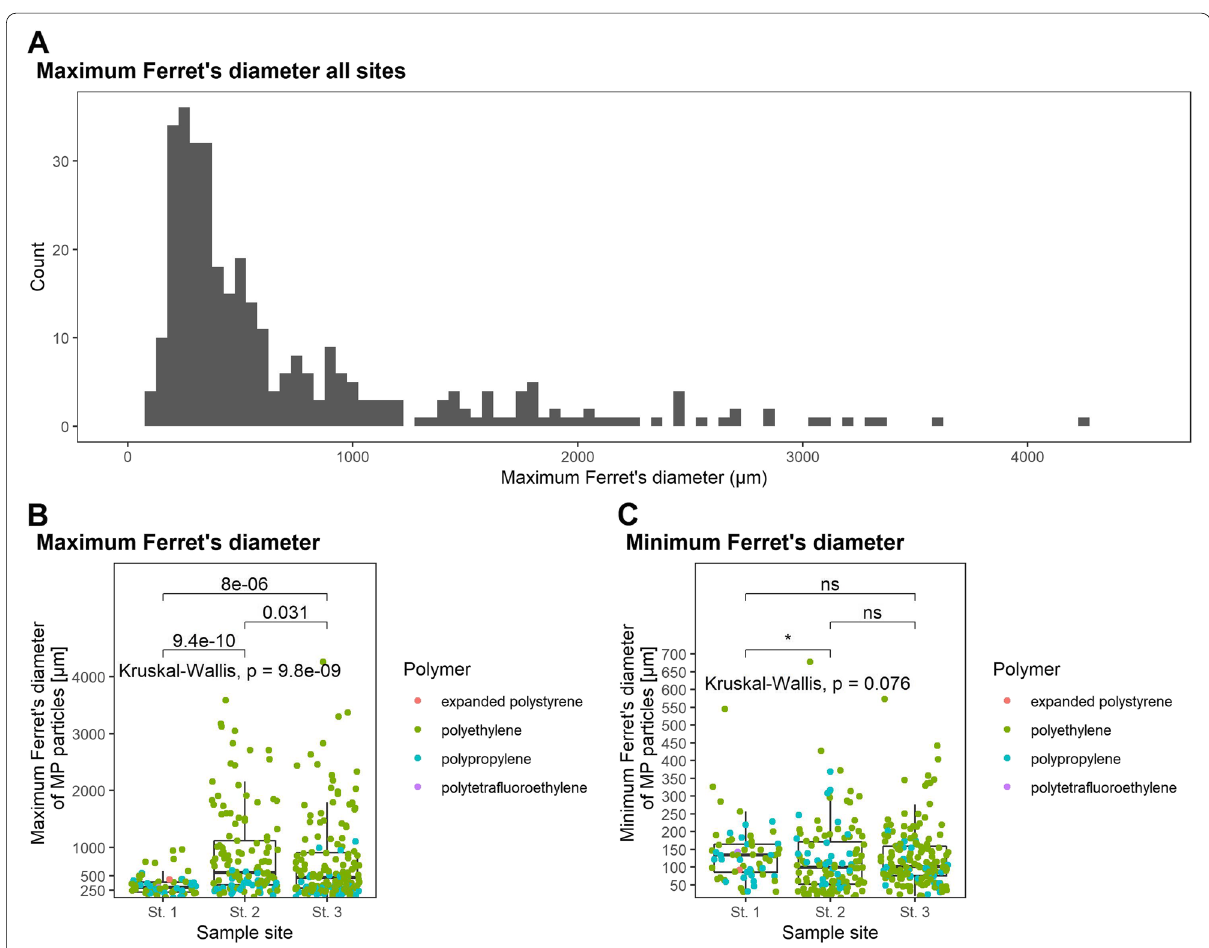
Fig. 5 Size of microplastic in sediment. A Maximum Ferret’s diameter (µm) of particles of all sites, B maximum Ferret’s diameter (µm) of microplastics at each of the three sites and C Minimum Ferret’s diameter (µm) of microplastics at each site. Asterix indicate level of significance: ‘ns‘ not significant, ‘*‘ = =